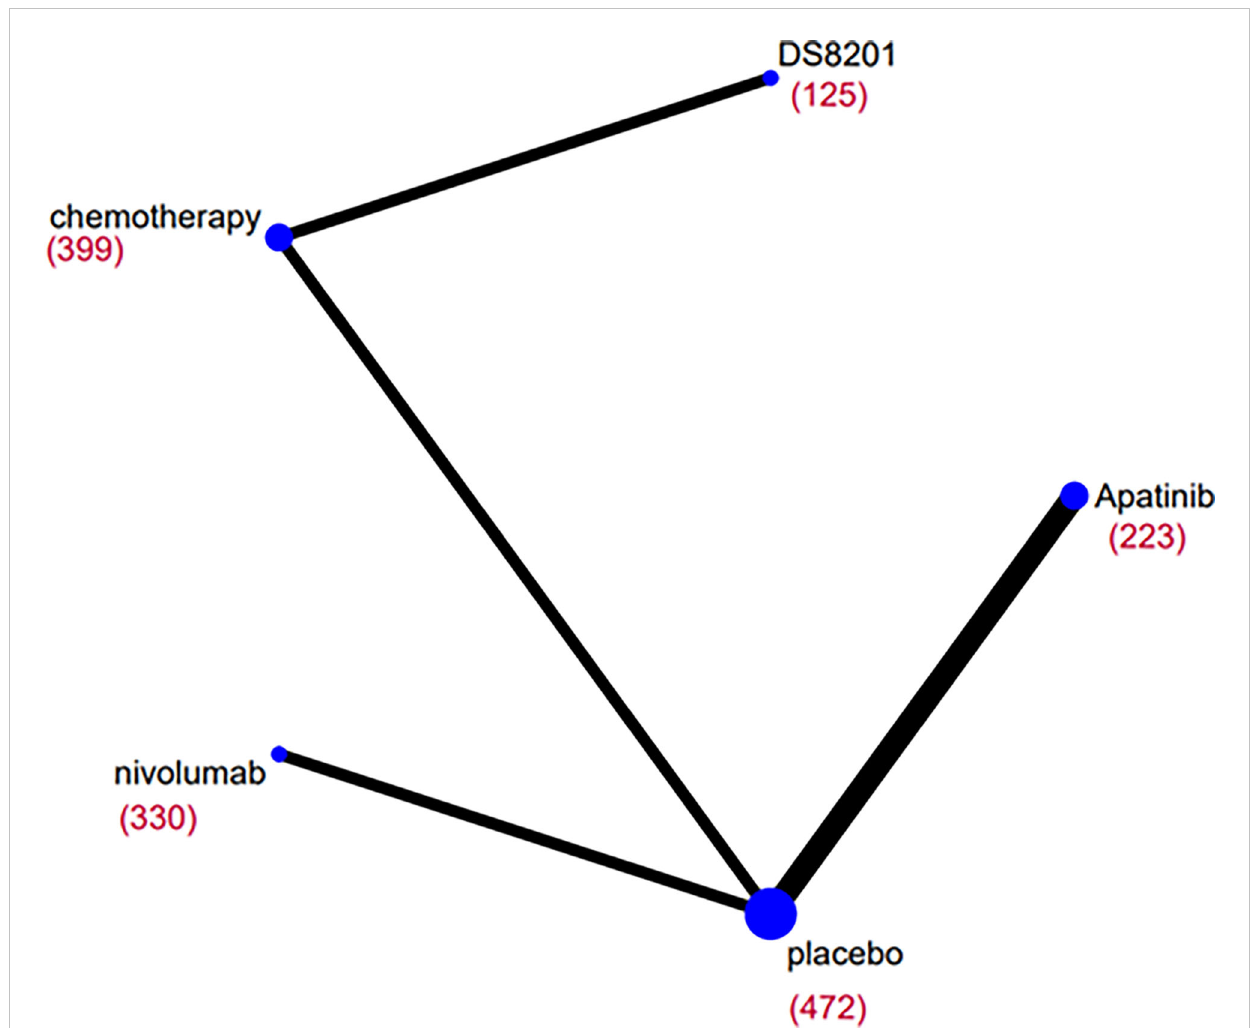
FIGURE 2 Network diagrams of comparisons on overall survival (OS) of treatments included in the network meta-analysis of the third-line treatments for advanced GC/GEJC. Each circular node represents a type of treatment. The size of the nodes and the thickness of the lines are weighted according to the number of studies evaluating each treatment and direct comparison, respectively. The total number of patients receiving treatments is shown in